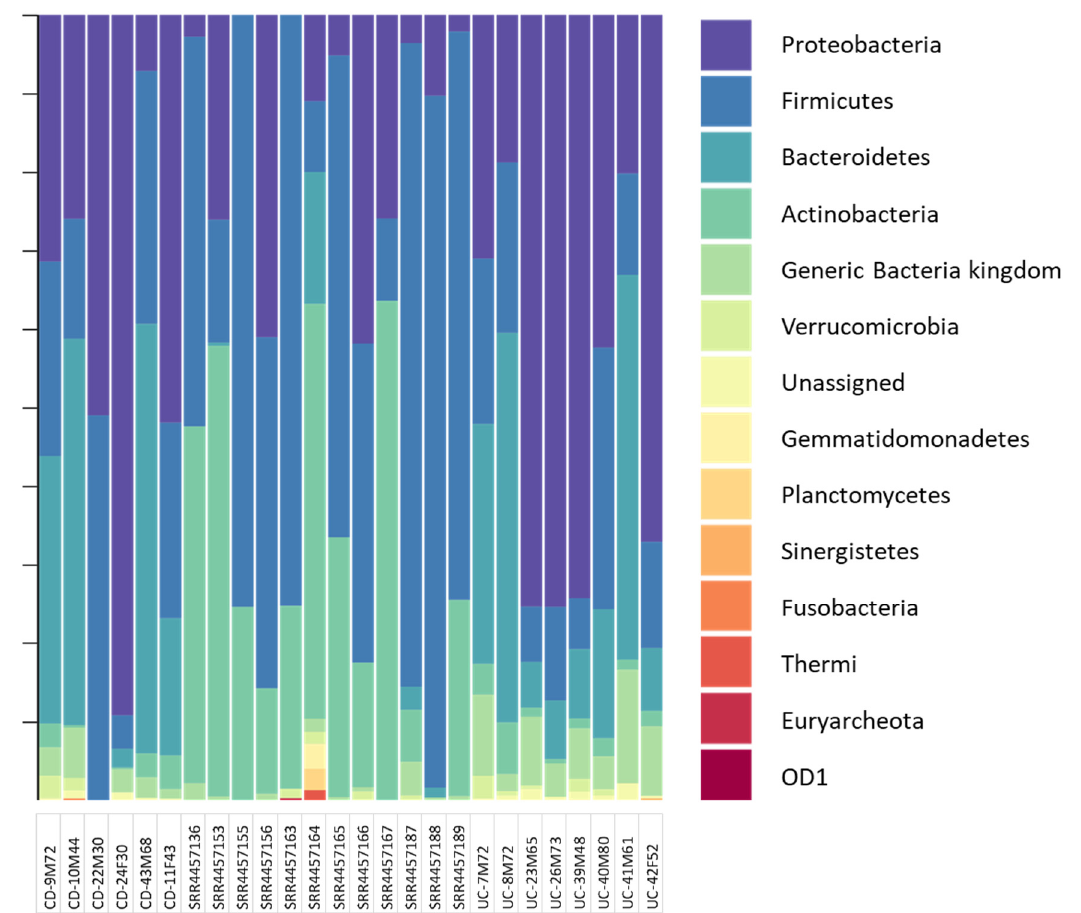
Figure 2. Microbiome composition. Bacteria community compositions at Phylum level, Relative abundance at phylum and genus level are in Supplementary Tables S3 and S4, respectively.